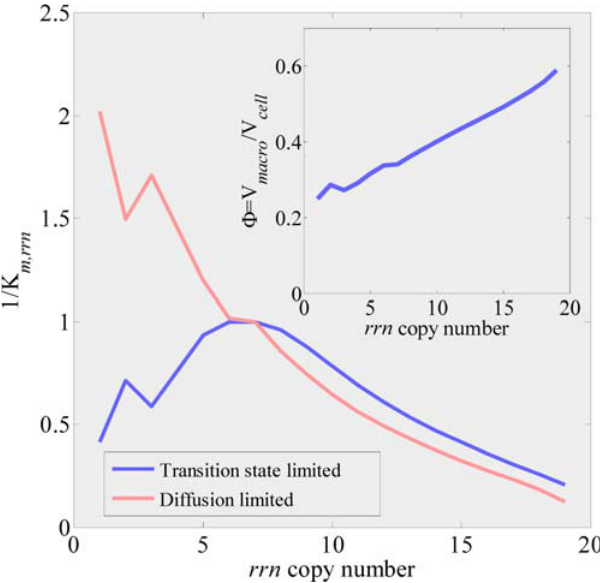
Figure 3. Predicted effect of crowding on the rRNA promoter binding affinity for two crowding scenarios. In the transition state scenario, binding affinities initially strengthen as macromolecular crowding is increased due to increased entropic forces, while in the diffusion limited scenario binding affinities weaken as macromolecular crowding is increased due to increased diffusion times. In both cases, binding affinities weaken when macromolecular crowding is increased beyond the WT crowding state due to increased diffusion times (see also Figures S8 and S2.4 in Text S1). Quantitatively, affinities can vary by up to a factor of 5 (transition state limited scenario) to 16 (diffusion limited scenario), measured as the ratio of the maximum and minimum values of binding affinities in the range of rRNA operon copy numbers considered. Similar results are obtained for RBS binding affinities. Binding affinities were normalized to WT values. Insert: